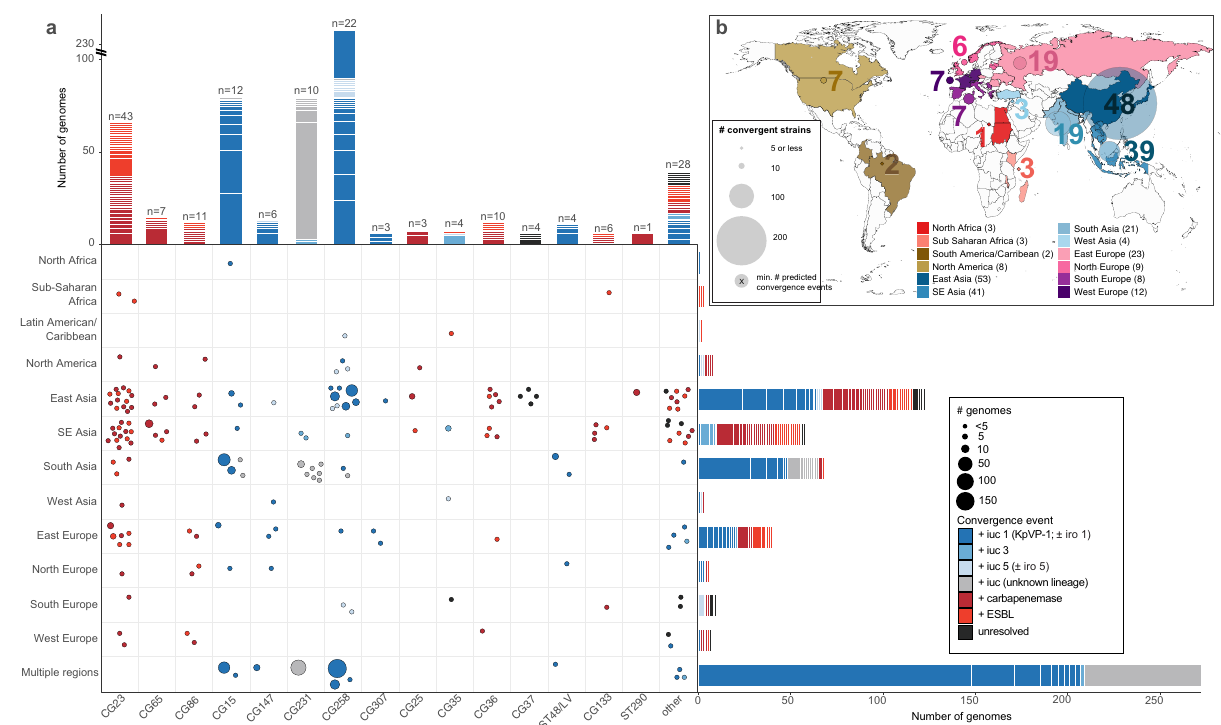
Fig. 7 Convergence of AMR and virulence determinants in the K. pneumoniae population, identi fi ed by Kleborate analysis of public genomes. a Geographical and lineage distribution of convergence events. Each circle represents a unique convergence event (i.e. a monophyletic clade harbouring both ESBL/carbapenemase genes and iuc ; see interactive tree at https://microreact.org/project/JDyan46yctyDh6weEUjWN, summary of events in Supplementary Data 7, assignment of genomes to events in Supplementary Data 2). Circles are scaled by the number of total genomes linked to the event and coloured to indicate whether convergence is inferred to have occurred via (i) acquisition of AMR gene/s (ESBL or carbapenemase/s) by a hypervirulent lineage, (ii) acquisition of an iuc -encoding plasmid by an AMR or non-AMR lineage, or (iii) unresolved means as per inset legend. Marginal barplots show the number of convergence events (colour blocks) and genomes (block heights) associated with each lineage (top) or geographical region (right). Lineages were de fi ned on the basis of multi-locus sequence types (STs), number of convergence events estimated for each is labelled at the top of each bar. b Distribution of convergent genomes by location. Countries from which convergent genomes were detected are coloured on the map; circles represent the number of convergent genomes detected in each UN-de fi ned geographical region (indicated by colour, as per inset legend), scaled and labelled with the minimum estimated number of unique convergence events speci fi c to each region (excluding inter-regional convergence events). The total number of convergence events affecting each region, including region-speci fi c and inter-regional convergence events, are given in brackets in the inset